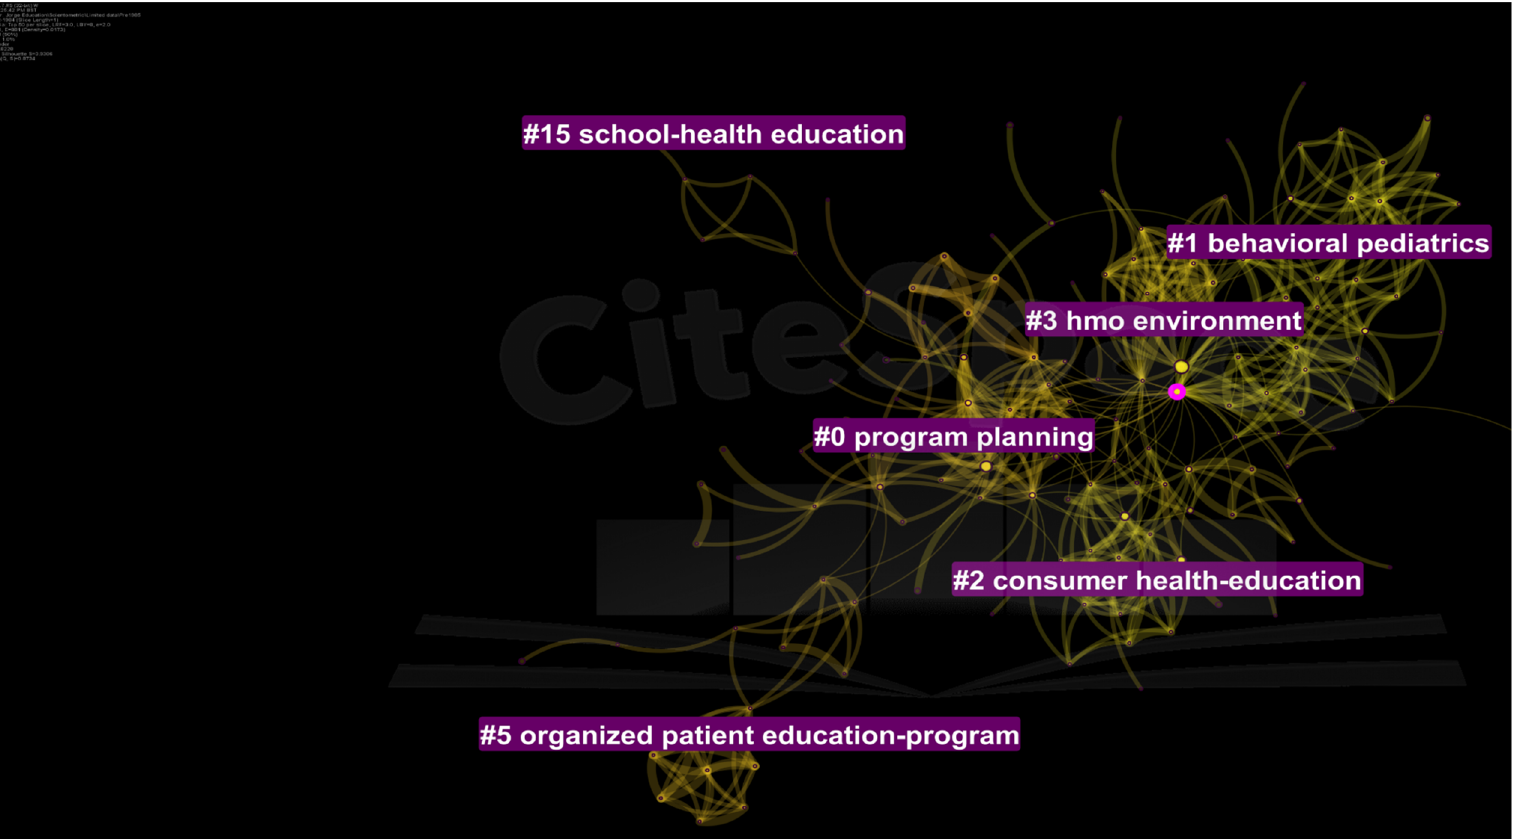
Figure 3. Top clusters of research in patient education research before 1985.